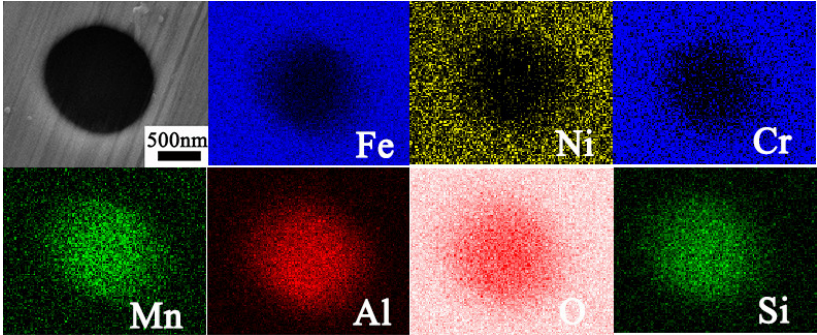
Figure 4. EDS surface scanning of inclusion in WM.